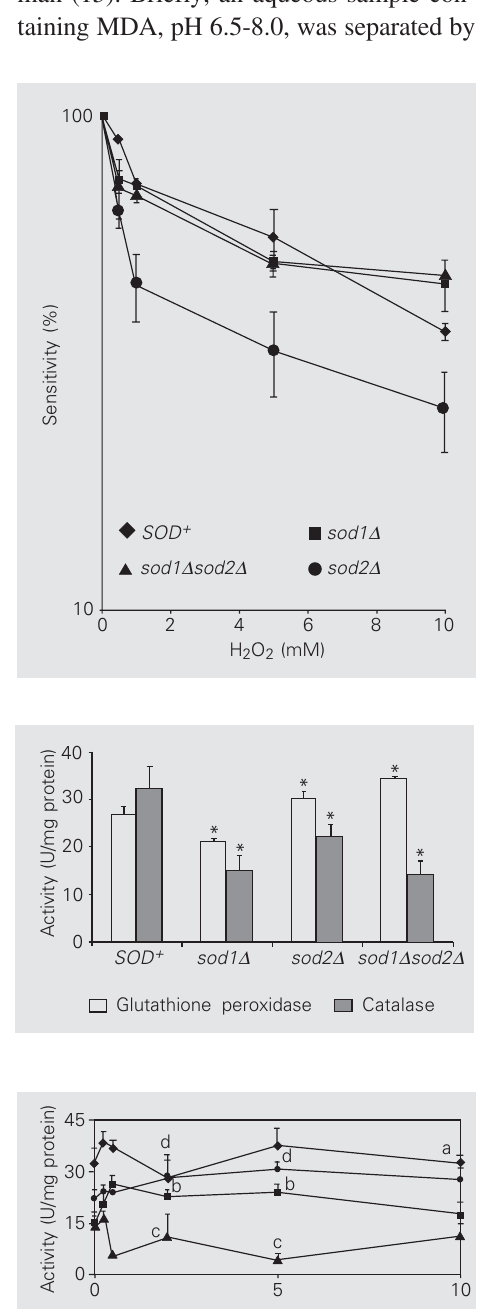
Figure 1. Sensitivity of sod null mutants exposed to H 2 O 2 . The strains used were: SOD + , sod1 ∆ , sod2 ∆ and sod1 ∆ sod2 ∆ . Data are reported as the mean ± SD of three independent experi- ments.